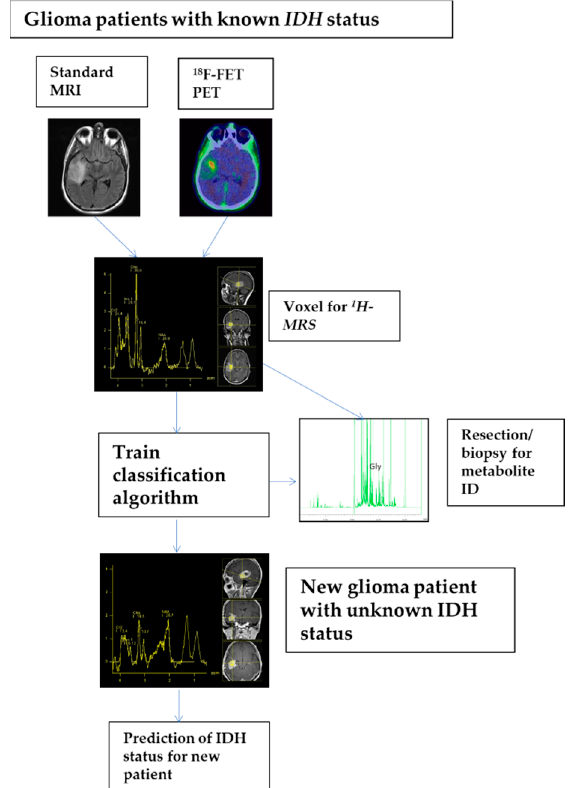
Figure 4. Detailed process description of analysis pipeline as it could be applied in clinical praxis.